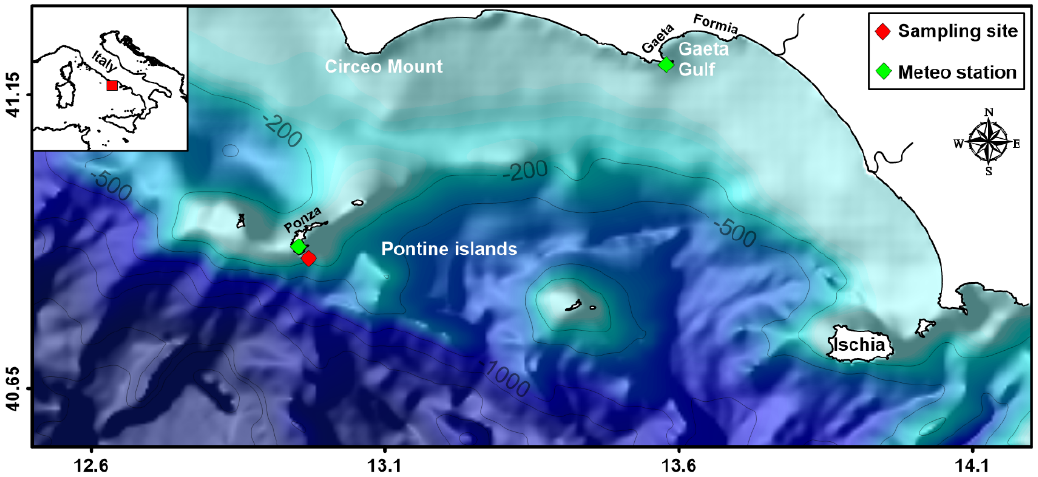
Figure 1. Regional view of the coastal site with the localization of the study area (Ponza Island, within the Pontine Island archipelago) and weather station used for the physical process analysis.